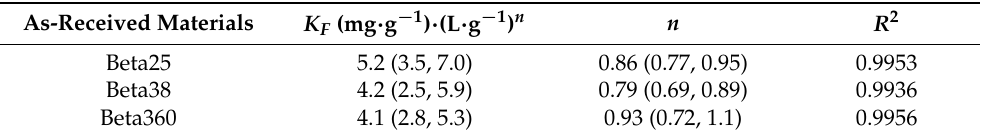
Table 2. Isotherm parameters for the adsorption of TOL on as-received BEAs estimated by non-linear fitting, according to the Freundlich model. The confidence limits at 95% of probability of the estimated parameters are reported in brackets.